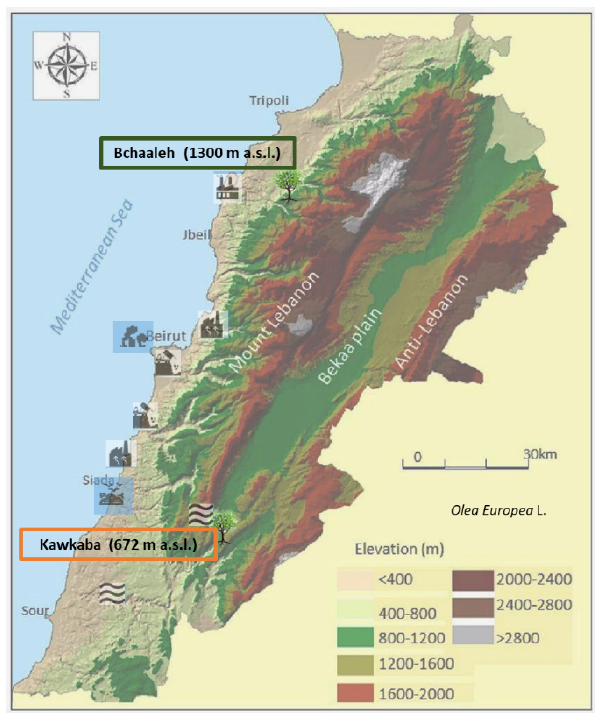
Figure 1. Site locations of the two selected focus areas (modified after Shared Water Resources of Lebanon, Nova Science Publishers,